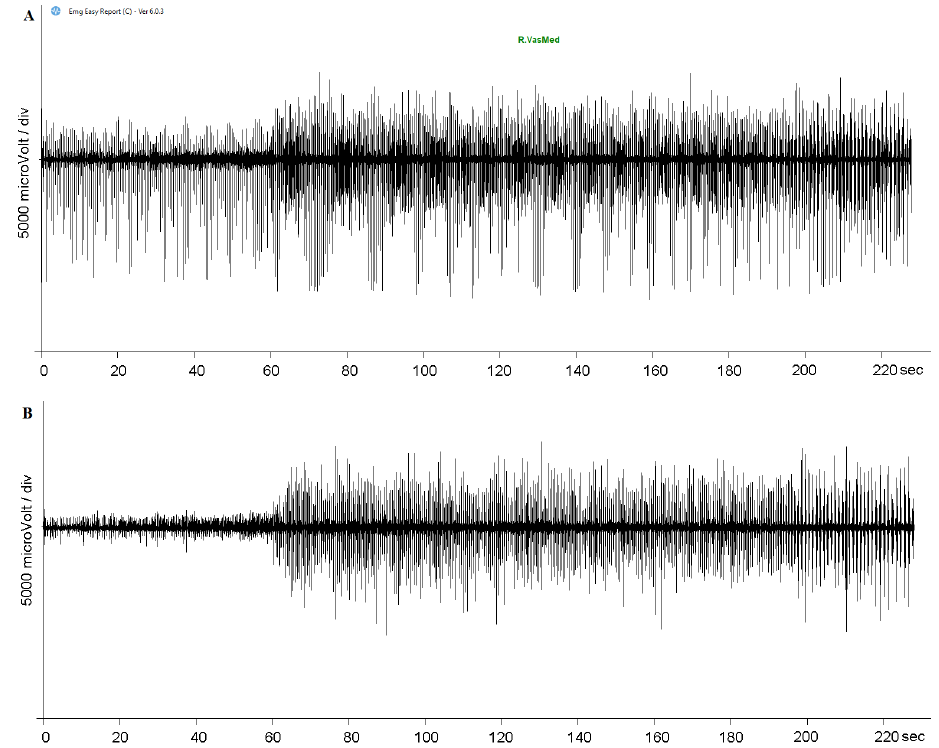
Figure 1. PEMF artifact removal with Easy Report 6.03.8 (Merlo Bioengineering, Italy). The raw EMG trace ( A ) was processed using a wavelet-based denoising filter and a specific algorithm in order to return a trace without PEMF artifacts ( B ).